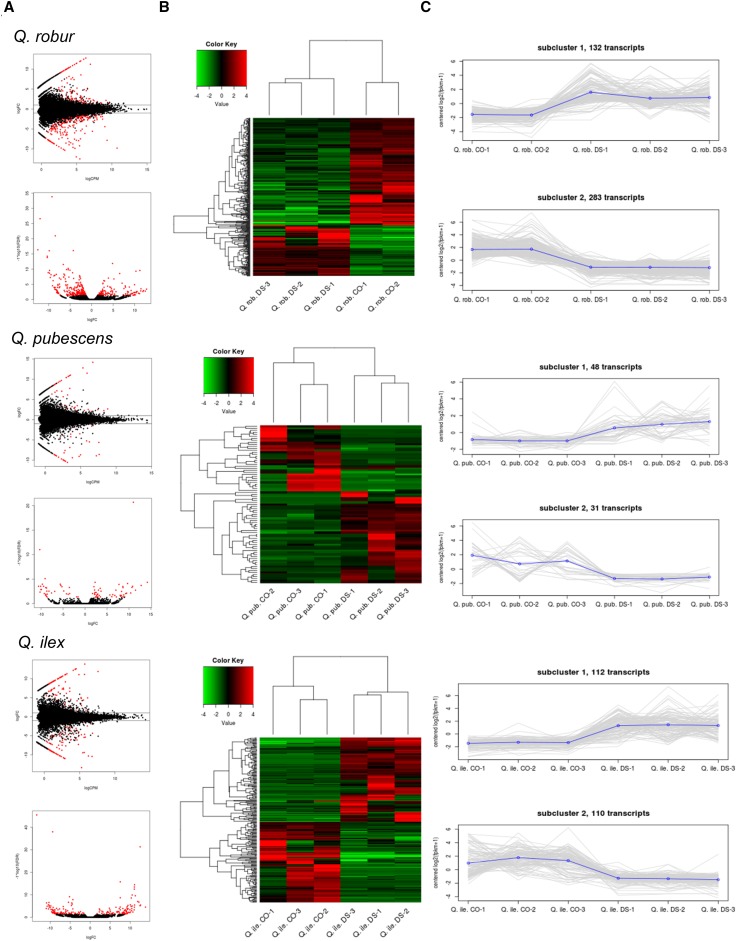
DEG analysis obtained using edgeR. MA plot in (A) shows log fold-change (logFC) vs. log average expression (logCPM). Significantly differentially expressed genes are shown in red. Volcano plot shows statistical significance (-log10 FDR) vs. log fold change (logFC). Hierarchical clustered heatmap in (B) showing significant differentially expressed gene abundance values (log2-transformed and mean centered FPKM values). Samples (control and drought stress) are clustered along the horizontal axis, differentially expressed genes along the vertical axis. Genes and samples are hierarchically clustered based on the Euclidean distance of gene abundance values and complete linkage clustering. Red and green color intensity indicate gene upregulation and downregulation, respectively. In (C) the expression patterns for each gene (grey) and the mean expression profile within that cluster (blue) is shown.